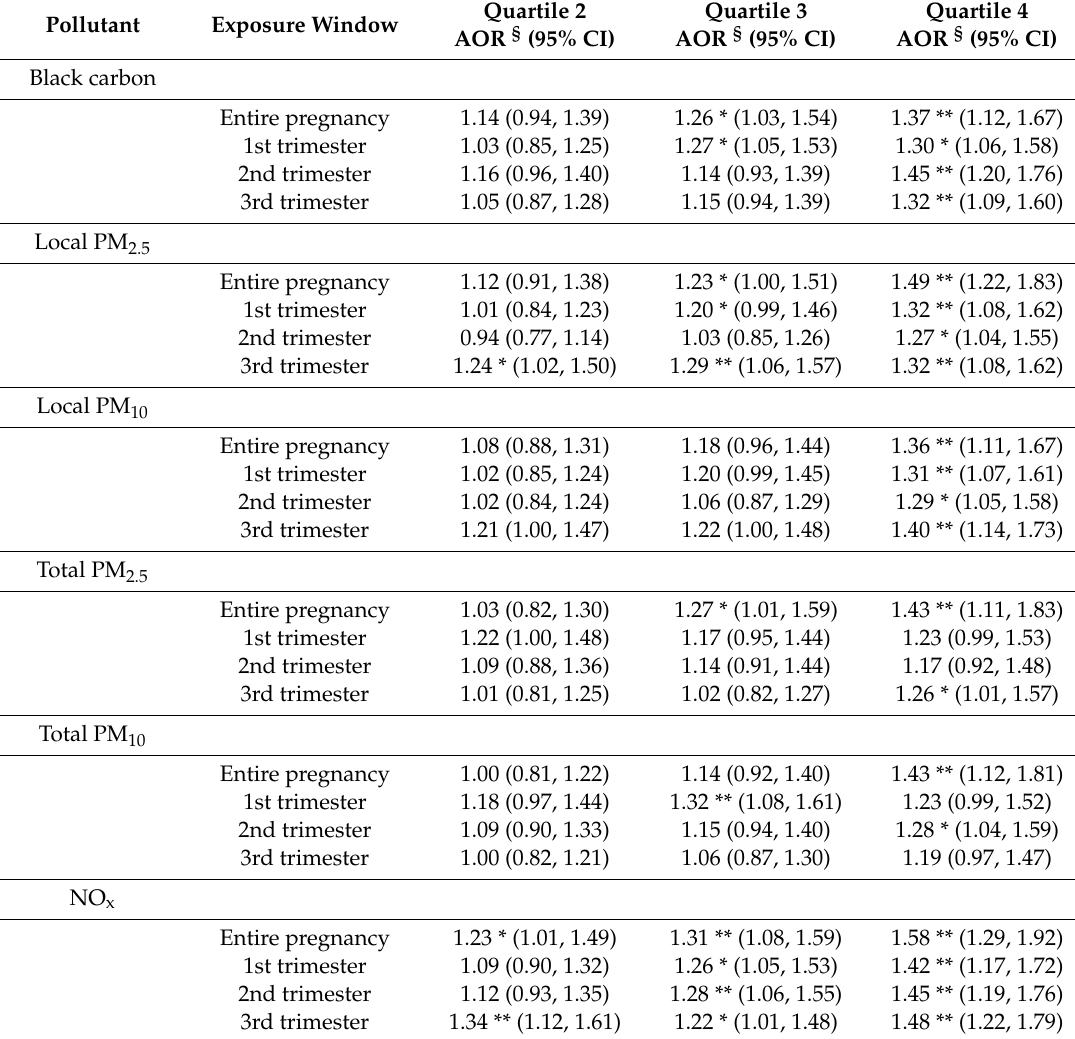
Table 4. Adjusted complete case analysis (CCA) for total preeclampsia in relation to the quartiles of all pollutants during each window of exposure (without the intermediate variables a